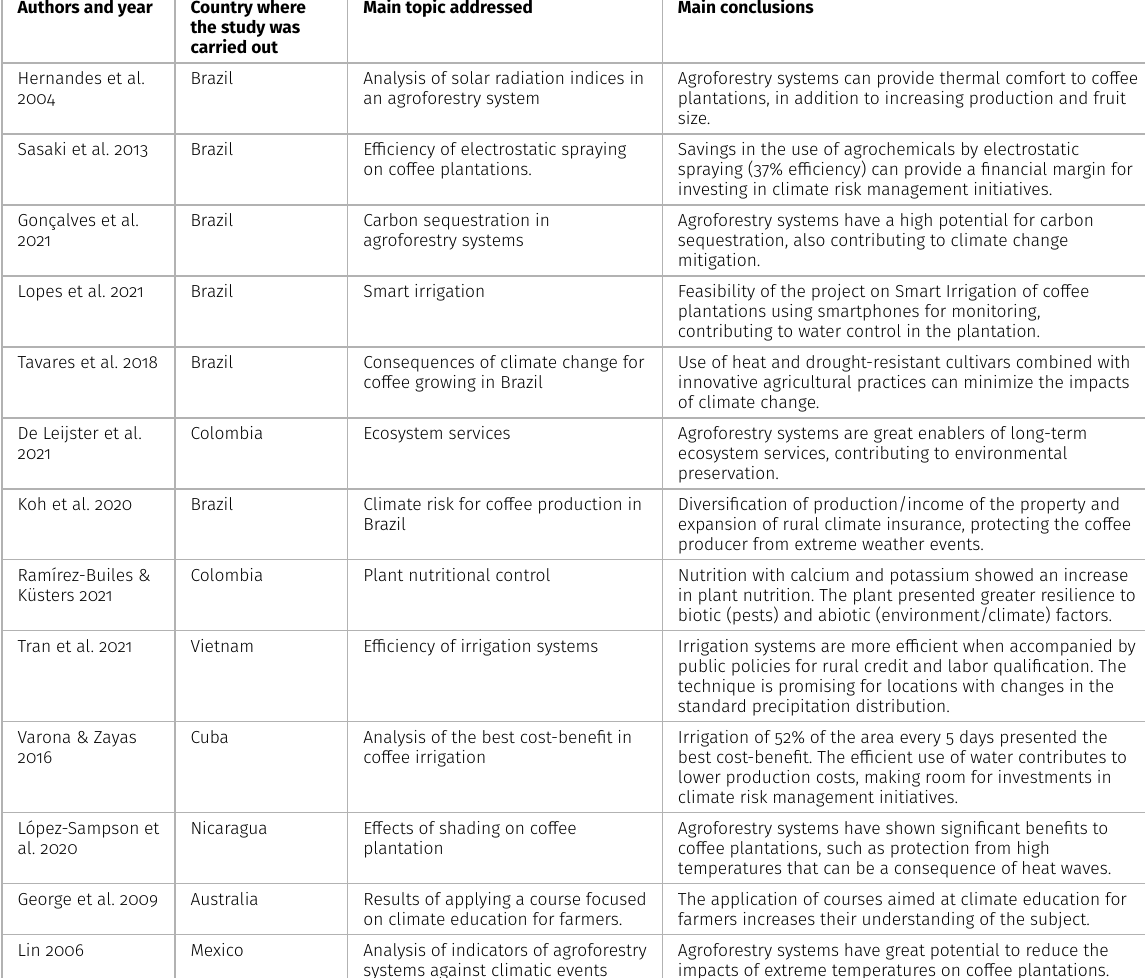
Table IV. Scientific articles showing proposals for climate risk management for coffee